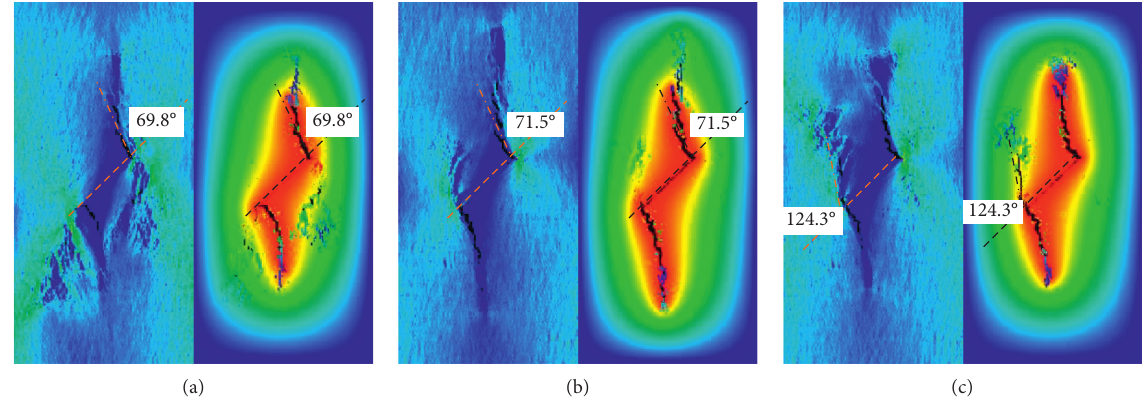
Figure 5: Typical results of crack propagation obtained by numerical simulations (a case with 45 °